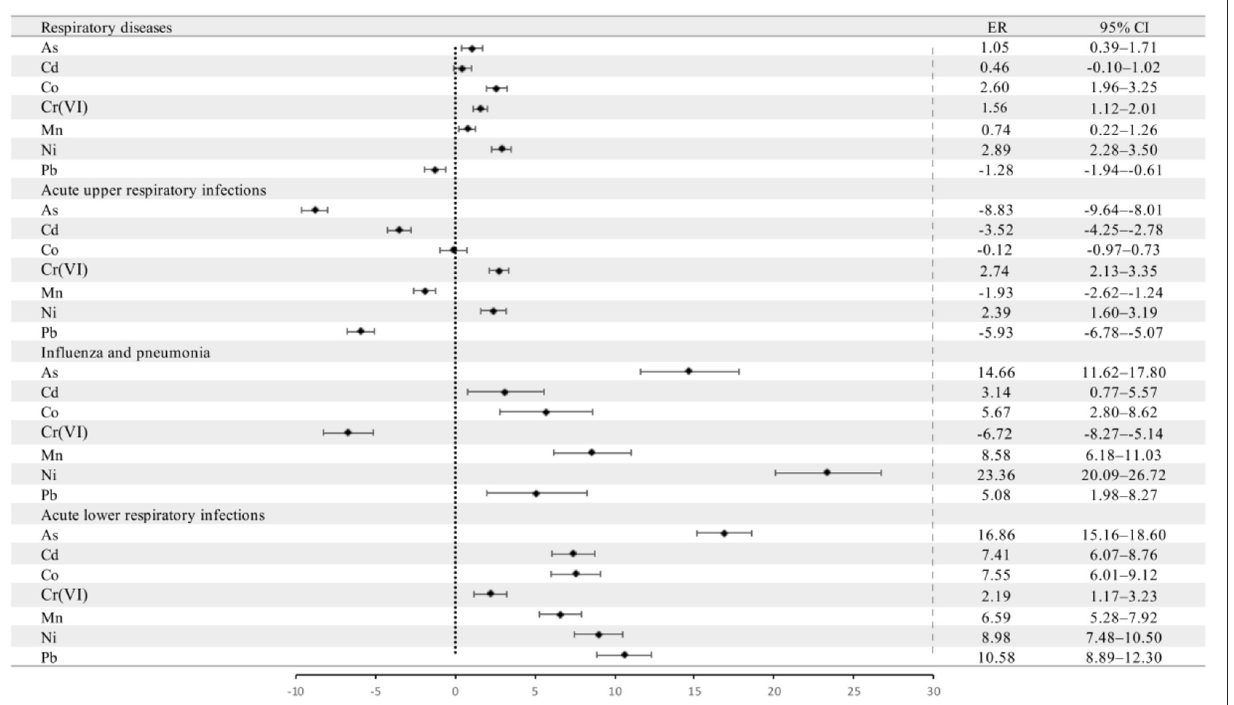
FIGURE5 Percentage change ( ER and 95% CI ) in pediatric outpatient visits for various respiratory diseases per IQR increase in the concentrations of As, Cd, Co, Cr(VI), Mn, Ni, and Pb in PM 2.5 at time lag0. CI , confidence interval, black dot indicates the mean excess risk, the black vertical line corresponds to 95% CI , and the vertical dotted line at 0 represents the reference